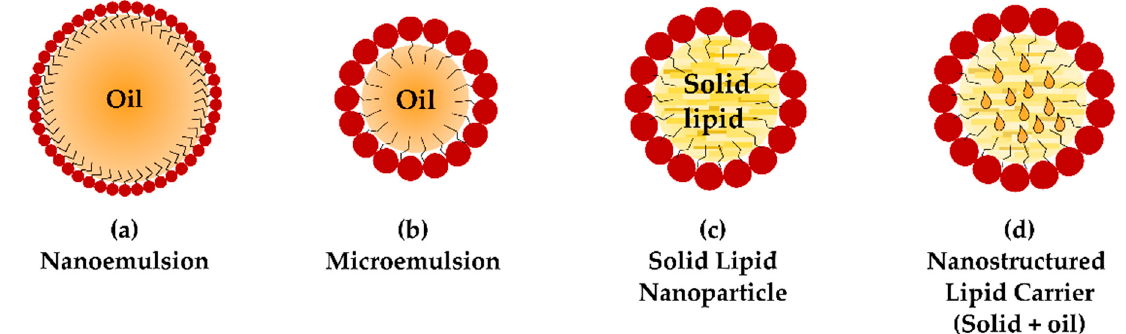
Figure 2. Schematic representation of different lipid-based nanocarriers. Nanoemulsions ( a ) and microemulsions ( b ) both present a liquid oily core but differ in their thermodynamic stability, the former being subject to typical emulsion instabilities, while the latter are thermodynamically stable. Solid lipid nanoparticles (SLN) ( c ) present a rigid lipid matrix with poor drug-loading capability, which is improved by partial substitution with an oil, leading to the so-called nanostructured lipid carriers (NLC) ( d ).